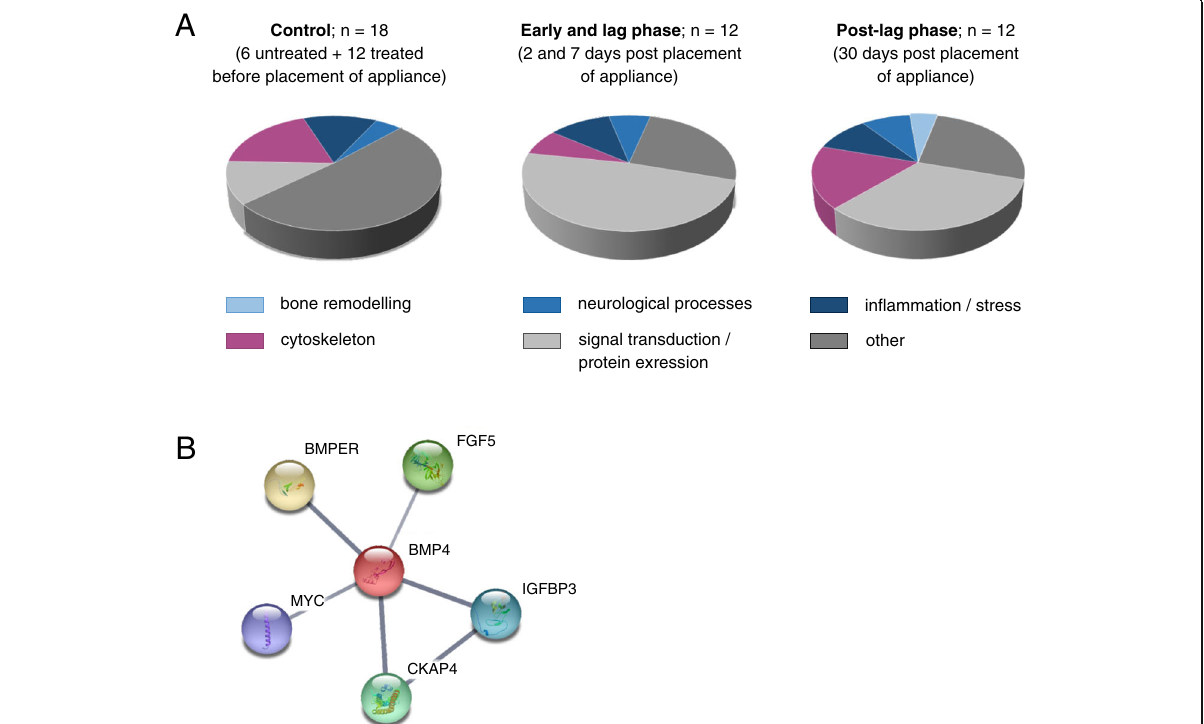
Fig. 2 Saliva protein expression after fixed orthodontic apparatus placement. A Left panel shows proteins expressed in the control samples, which include pre-placement sample pools (n = 12), and control samples (n = 6) (no orthodontic therapy). The center panel presents proteins expressed in the early and lag phase of the OTM, which includes post placement (0 h), as well as two and then seven days post therapy (n = 12). The right panel shows proteins expressed in the post-lag phase of OTM at 30 days post placement when bone remodeling occurs (n = 12). Proteins are grouped according to the physiological processes they are part of. B Proteins interaction network related to saliva BMP4 in the post- lag phase, as predicted by STITCH software, version 5.0 (http://stitch.embl.de). Line thickness indicates strength of data support. BMP4 - bone morphogenetic protein 4; BMPER - BMP-binding endothelial regulator protein; FGF5 - fibroblast growth factor 5; IGFBP3 - insulin-like growth factor-binding protein 3; CKAP4 - cytoskeleton-associated protein 4; MYC - myc proto-oncogene